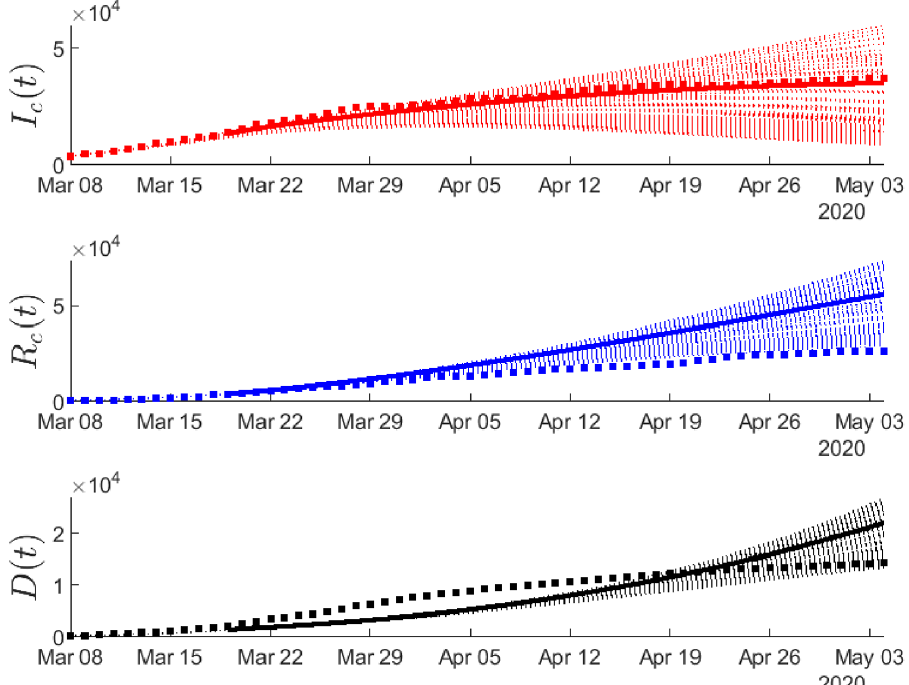
Fig 5. Estimated number of the infected (aka “confirmed” infected) cases with mild and severe symptoms ( I c ( t )), recovered ( R ( t )) and deaths ( D ( t )) resulting from all simulations from March 8 (the day of the lockdown of all c Italy) until May 4 (see in Methodology). Based on the Google released data (see in Methodology), we considered a (1- 0.4)(1-0.2) reduction of the “effective” transmission rate from March 9 until March 19 compared to the period February 21-March 8, and then considering a (1-0.65)(1-0.2) reduction due to the even stricter mobility limitation measures announced by the government on March 20 and March 21 (see in Methodology). Red dots correspond to the reported confirmed infected cases, blue dots correspond to the reported recovered cases and black dots correspond to the reported deaths (up to May 4, 2020). Solid lines correspond to the mean values of I c ( t ), R c ( t ) and D ( t ), over all runs (see in